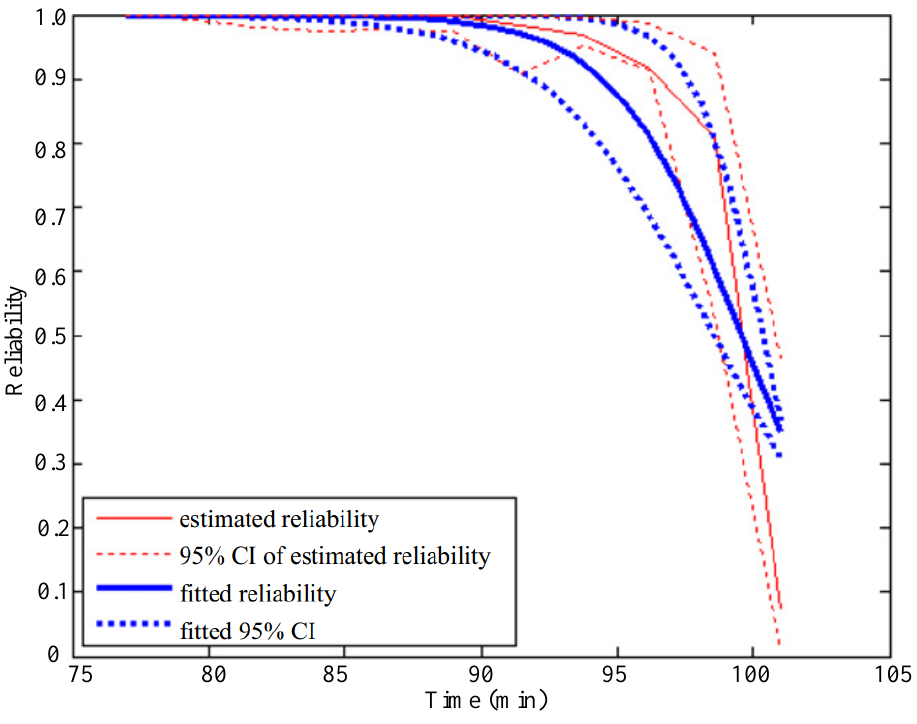
Figure 10. Reliability assessment result of the test tool determined by Chen’s method